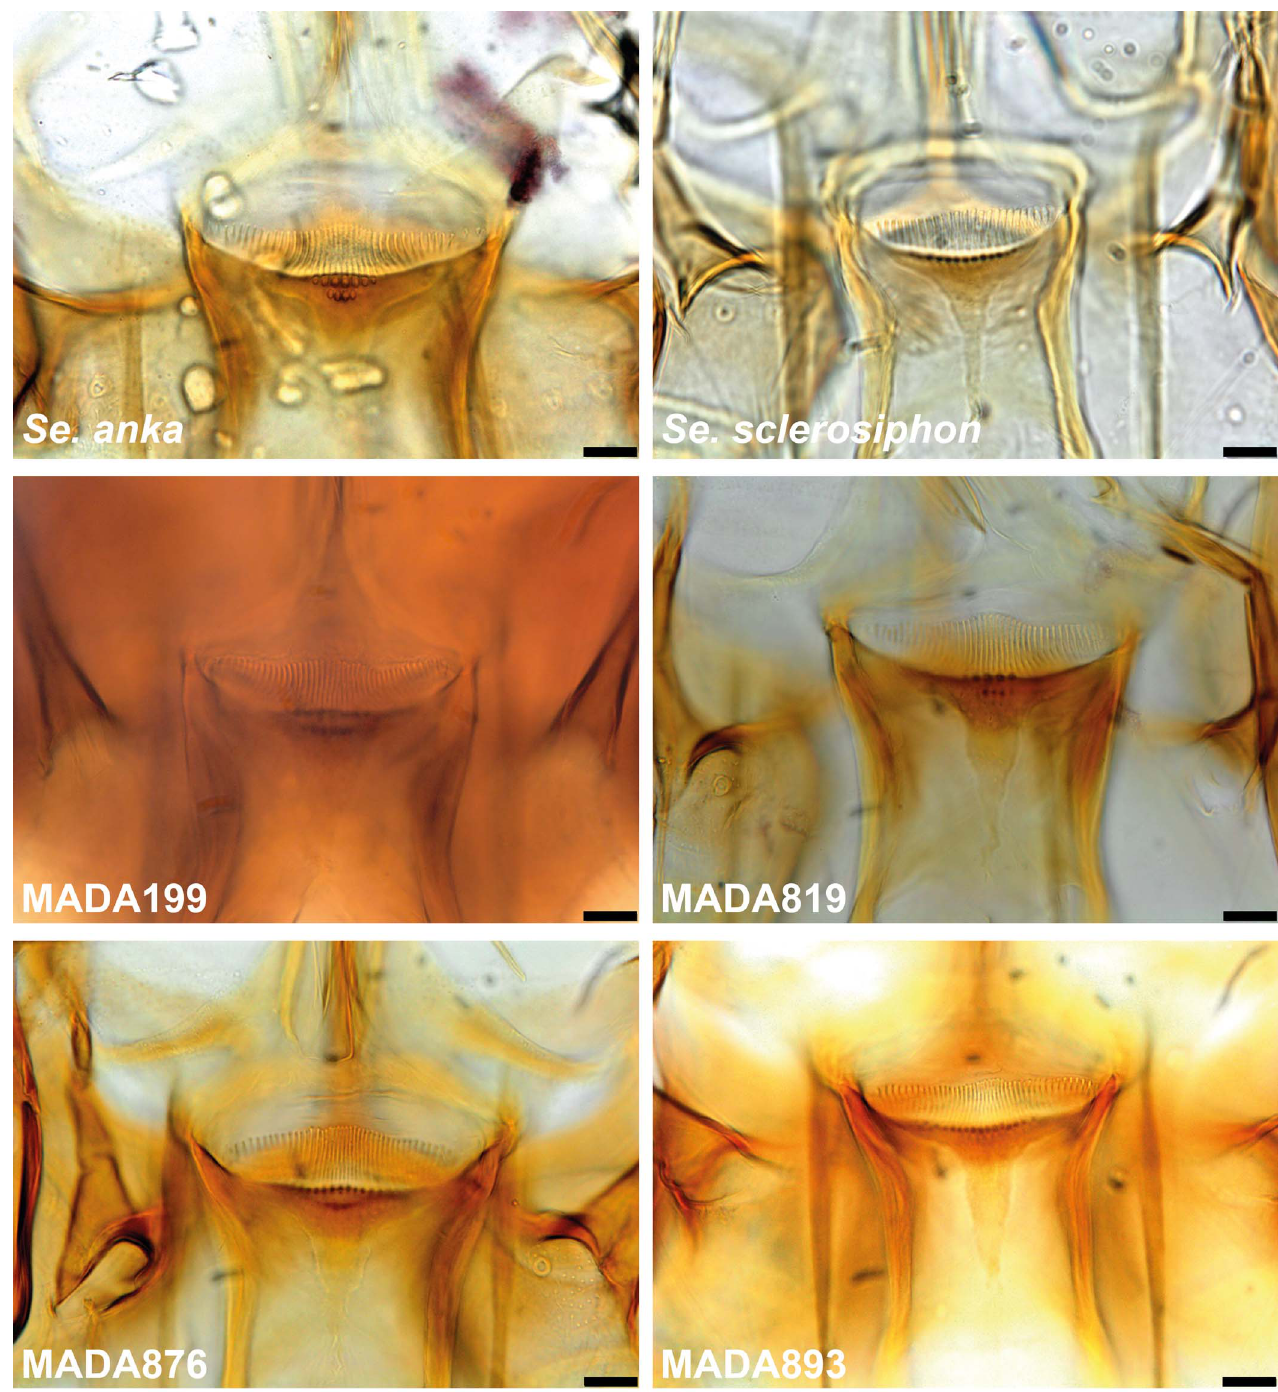
Figure 17. Comparison of the cibarial armatures of Sergentomyia anka and Se. sclerosiphon females with those of specimens identi fi ed as Se. cf. anka and isolated by molecular analyses. Bars = 10 l